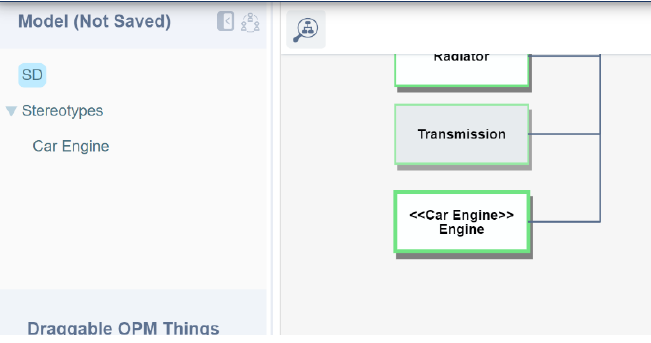
Figure 8. Engine is anchored into the <<Car Engine>> stereotype.